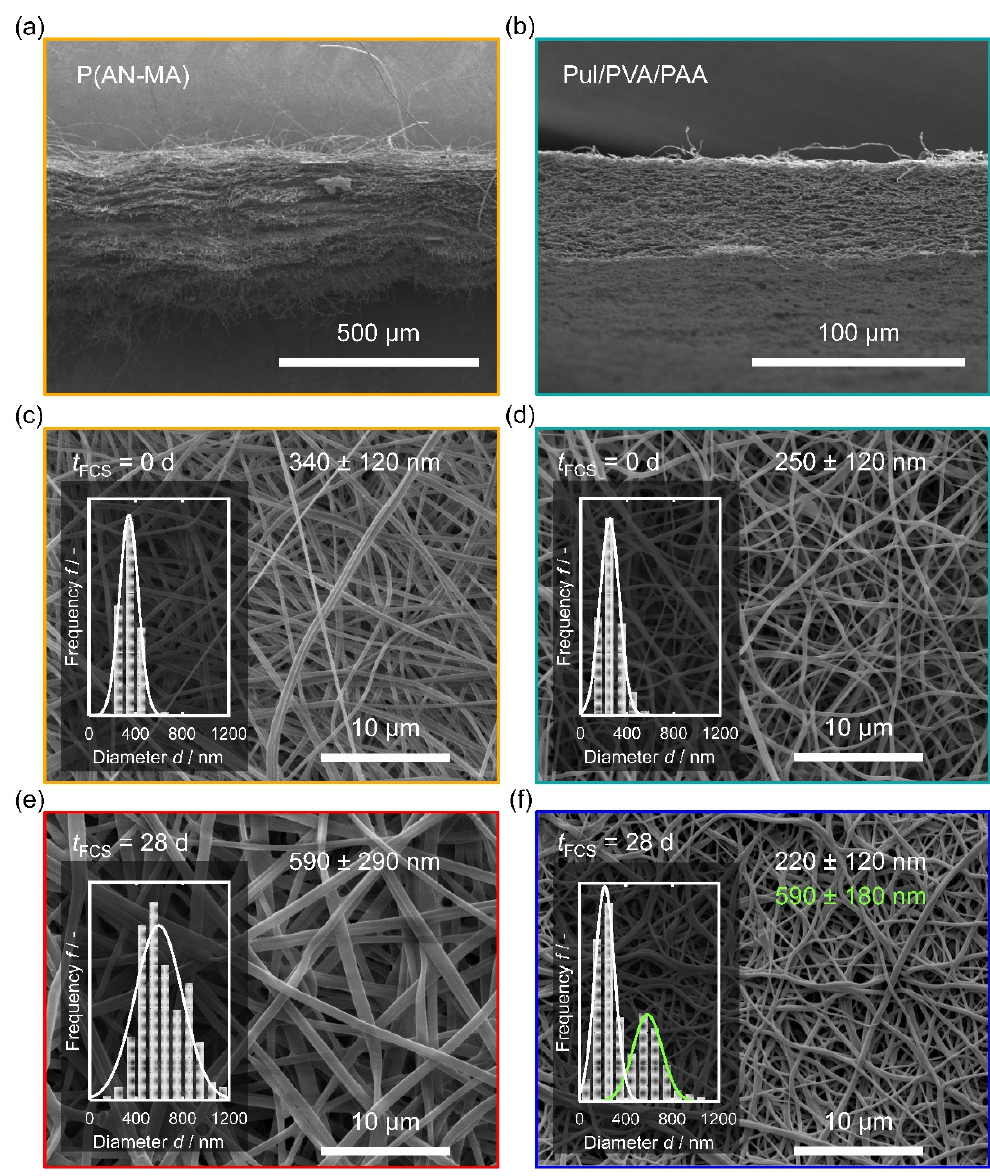
Figure 2. SEM images of P(AN-MA) and Pul/PVA/PAA nanofiber mats showing cross-sections ( a , b ) and top views before ( c , d ) and after 28 days of culture conditions in FCS ( e , f ). The insets in ( c – f ) show histograms of the nanofiber diameters. Inset ( f ) shows a bimodal fiber distribution after 28 days of incubation caused by attaching fibers (green).